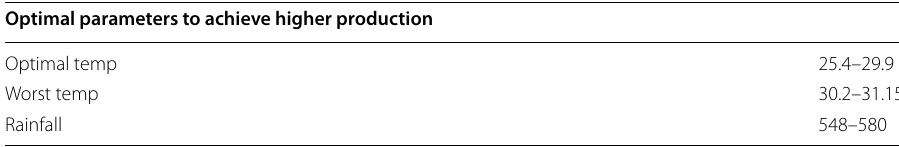
Table 5 Optimal parameters to achieve higher production Optimal parameters to achieve higher production